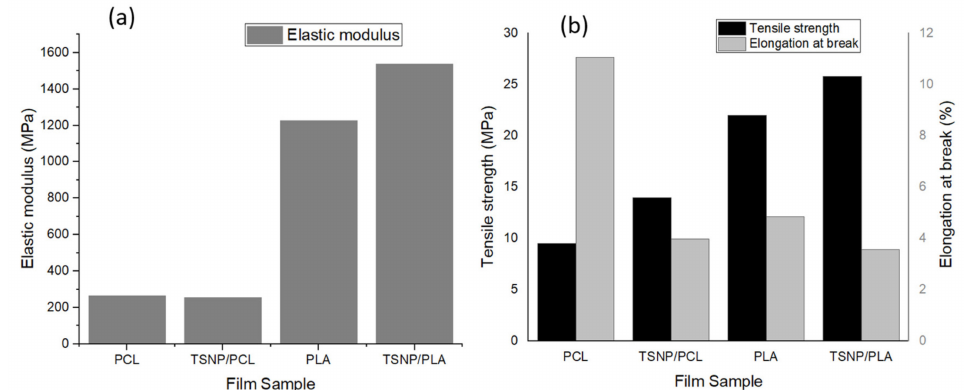
Figure 8. ( a ) Elastic modulus, ( b ) Tensile strength and Elongation at break of treated and bare PCL and PLA